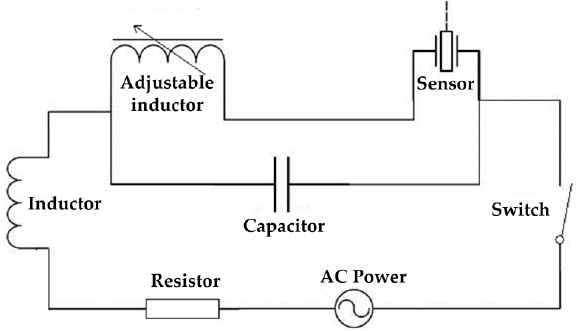
Figure 5. Schematic diagram of the excitation resonant circuit.